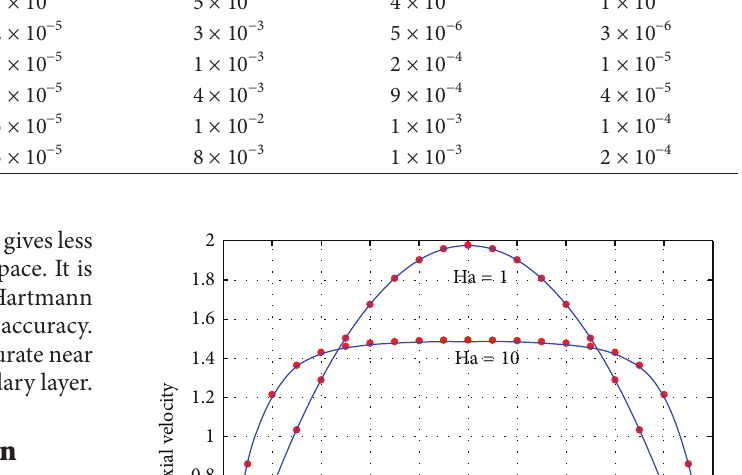
Table 3: Absolute error in the axial velocity 𝑤(𝑥, 0.5, 90) for four different cases when Re = 300 . 𝑥 Ha = 2 Ha = 10 Case-I and Case-II Case-II and Case-III Case-III and Case-IV Case-I and Case-II Case-II and Case-III Case-III and Case-IV